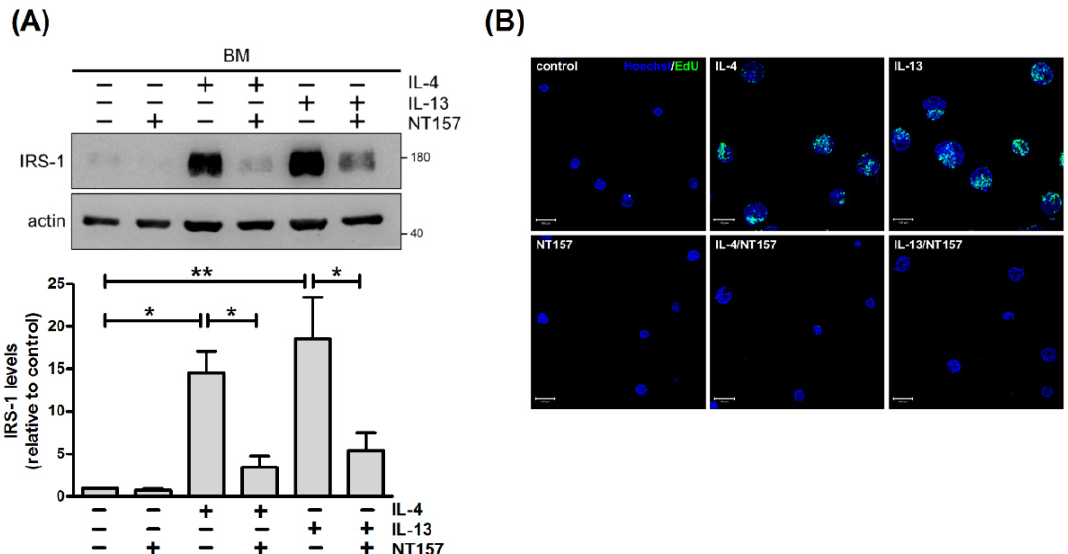
Figure 7. IRS-1 inhibitor NT157 suppresses IL-4- and IL-13-stimulated cell proliferation. Mammary cells cultured on a basement membrane (BM)-like matrix, Matrigel, were untreated or treated with NT157 (5 µ M), IL-4 or IL-13 for 2 d. ( A ) Total cell lysates were analyzed by immunoblotting with antibodies to IRS-1 and actin. Actin was used as a loading control. Data were quantified, normalized to loading control and expressed as fold change relative to control ( n = 4). * p < 0.05, ** p < 0.01. ( B ) Prior to harvesting, cells were pulsed with EdU (10 µ M; green) for 8 h. Nuclei were stained with Hoechst 33342 (blue). Scale bar, 100 µ m.